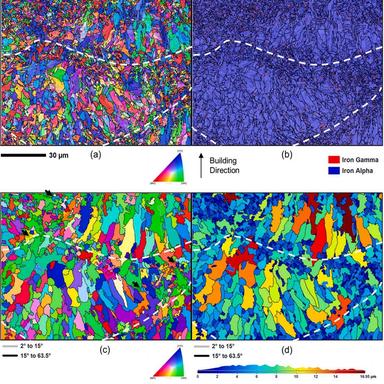
EBSD maps of the sample in H900-4 h condition: a) IPF map showing no preferential orientation, b) phase map showing the presence of retained austenite (in red), c) the IPF map of the reconstruction of the parent microstructure with austenite grains formed by a massive transformation in the HAZ (black arrows) and (d) the grain size distribution of parent austenite, showing reverted austenitic grains at the top of melt pools. The approximate contours of the melt pools are marked in white. (For interpretation